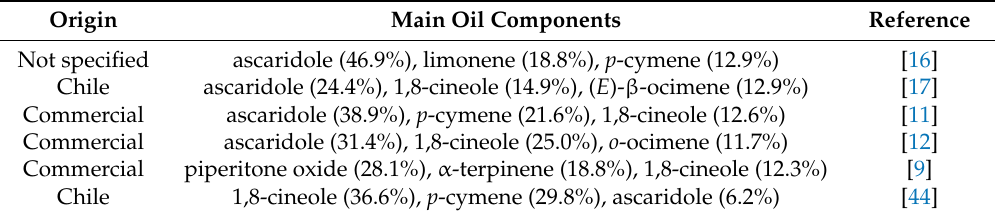
Table 5. Major components (in decrescent order) of (boldo essential oil, BEO) reported in previous